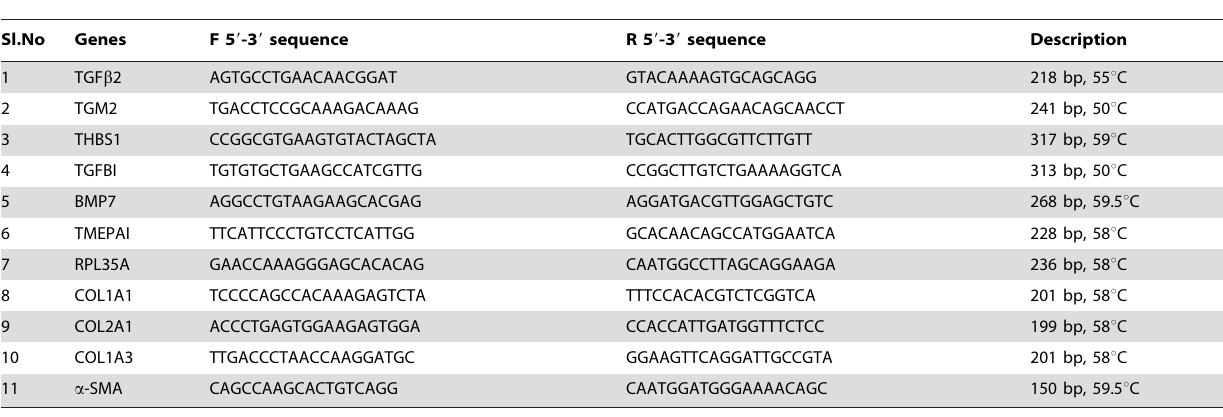
Table 1. List of primer sequences used for RT- PCR.